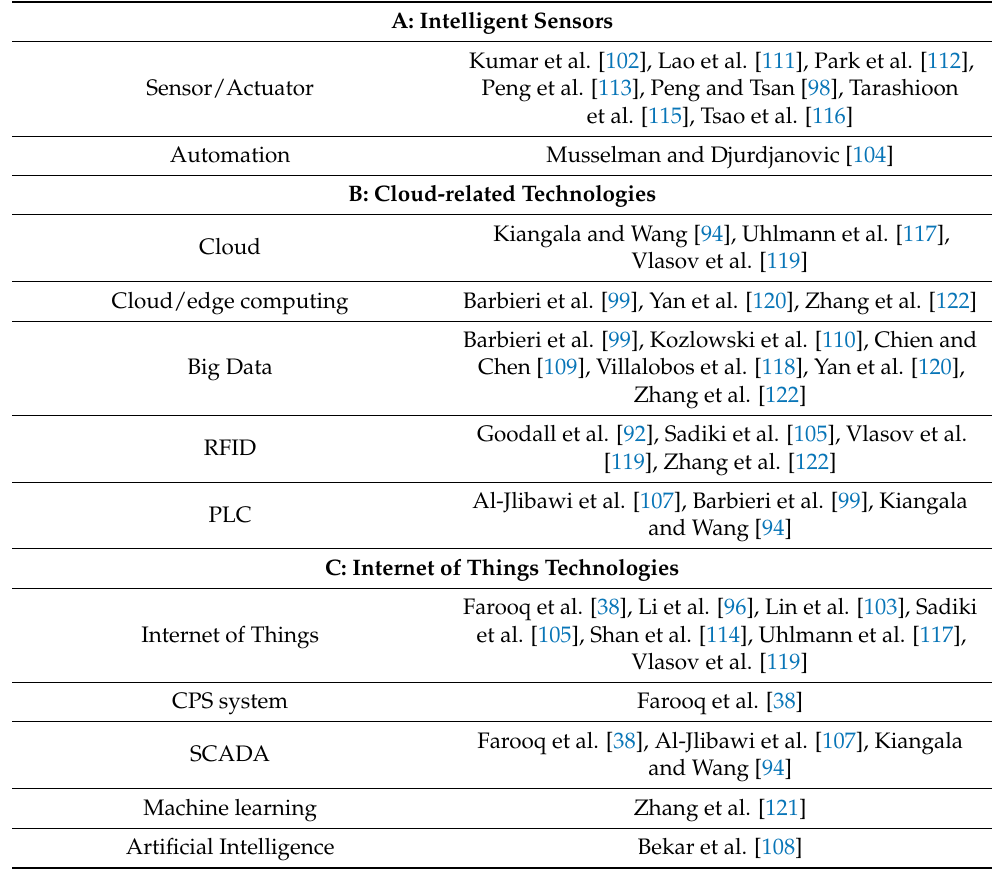
Table 7. Classification of Industry 4.0 technologies based on obtained keywords’